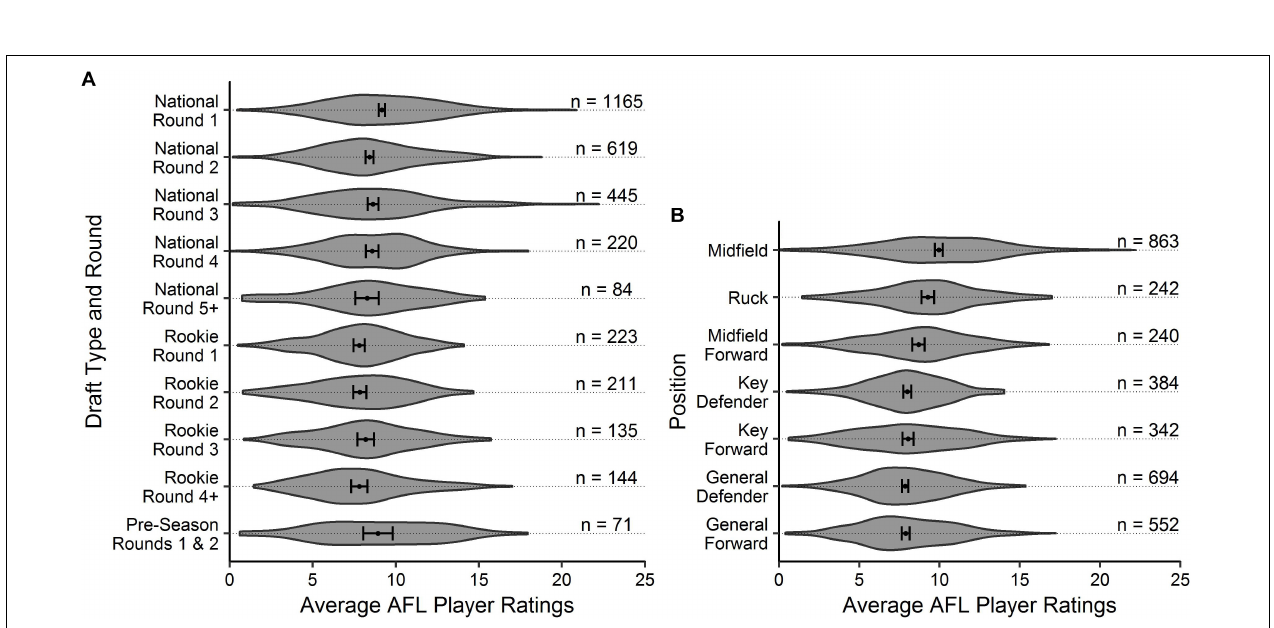
Frontiers in Psychology |